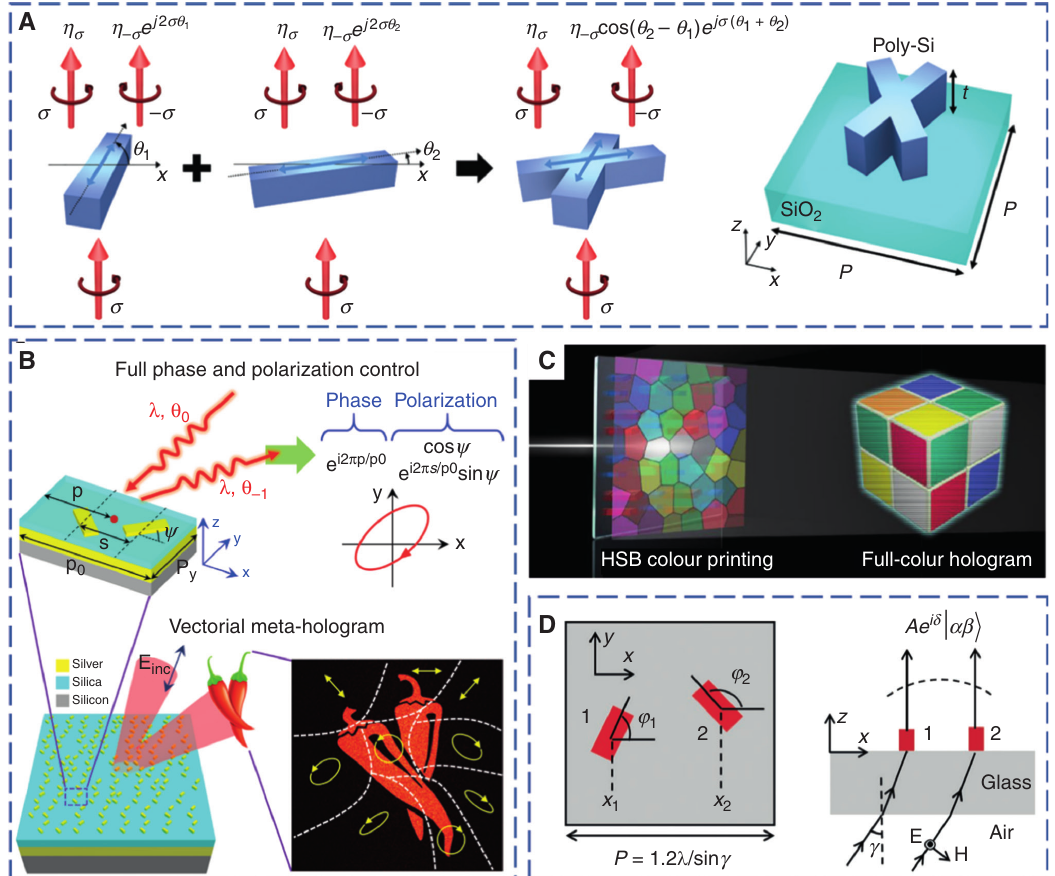
Figure 15: Metasurfaces with a unit cell composed of two identical nanostructures. (A) Complex amplitude manipulation based on X-shaped nanostructures [110]. (B) Unit cell composed of two identical but separate nanorods for manipulation of the phase and polarization state of light simultaneously [111]. (C) Complex amplitude manipulation with a pair of nanostructures to conduct simultaneous full-color holography and HSB color printings [115]. (D) Unit cell composed of two identical but separate nanostructures for manipulation of intensity, polarization states, and topological charges of the vortex beam simultaneously [116]. Reprint permission obtained from [110, 111, 115,